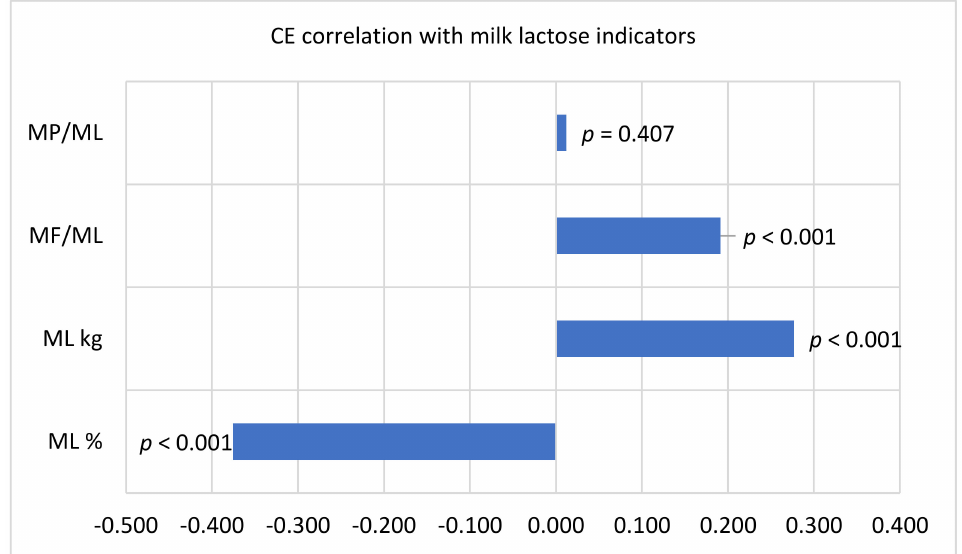
Figure 1. Spearman’s correlation coefficient between cows’ CE scores and milk lactose indicators. ML/MP = milk protein %/lactose % ratio; MF/ML = milk fat %/lactose % ratio; ML = milk lactose. We found a statistically significant ( p < 0.001) negative correlation of CE with cows ML% ( r = 0.376) and positive correlation coefficients with ML yield (kg; r = 0.277) and MF/ML % ratio ( r =